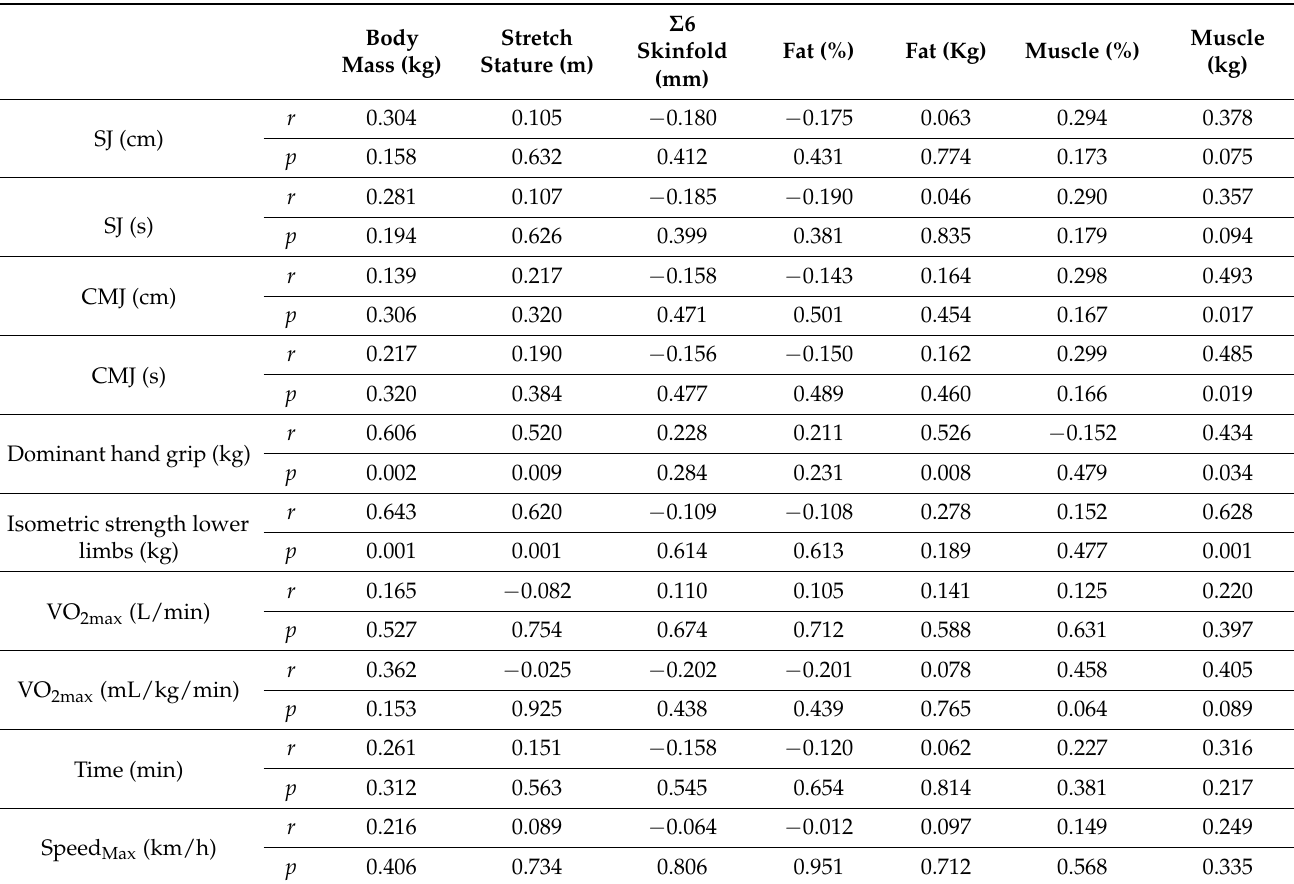
Table 6. Relationships between anthropometry and body composition parameters and physical condition parameters in women soccer players.